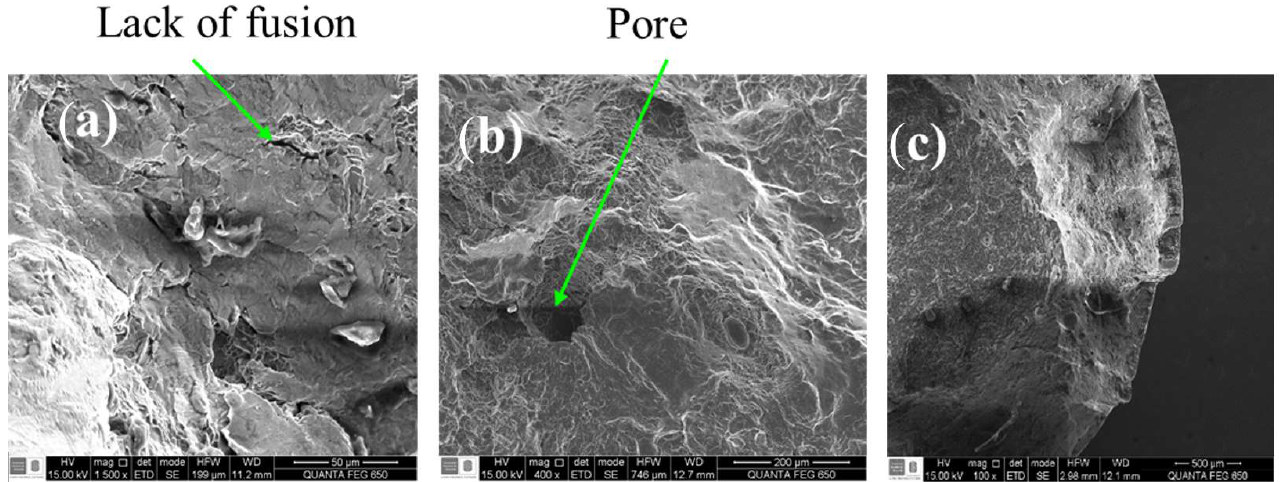
Figure 13. SEM micrographs showing fracture morphology: ( a ) lack of fusion; ( b ) pore on the matrix; ( c ) general view of fractured surface.